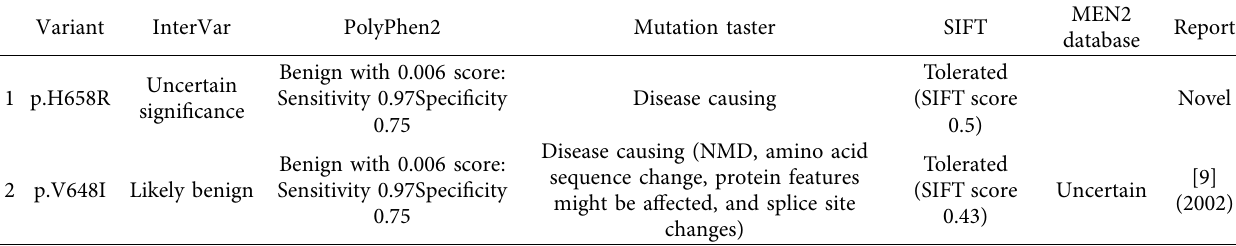
Table 2: Variants according to in silico